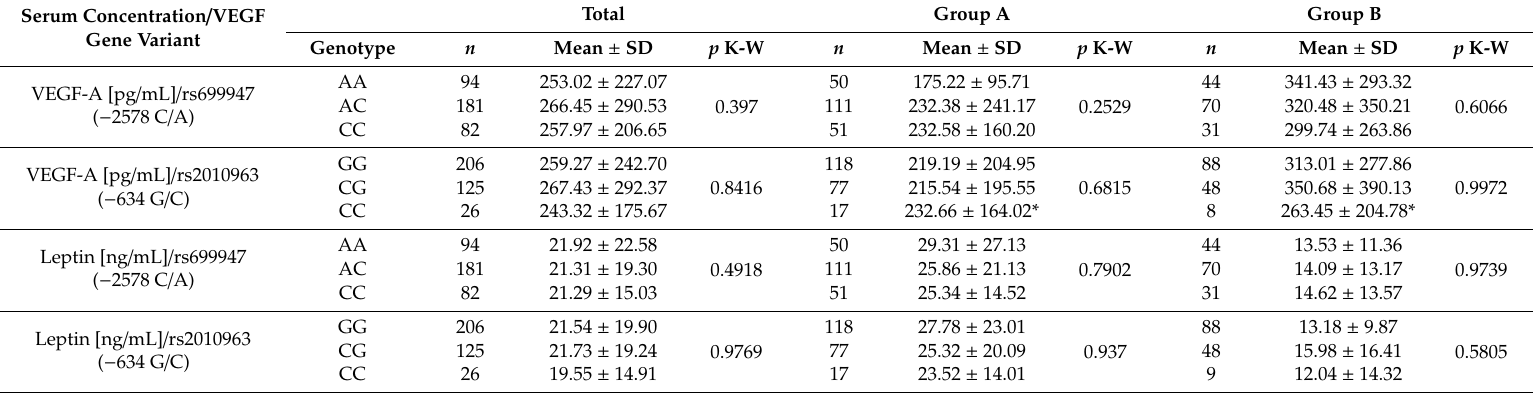
Table 5. Comparison of VEGF-A and leptin serum concentrations between particular genotypes of VEGF gene variants. Serum Concentration / VEGF Gene